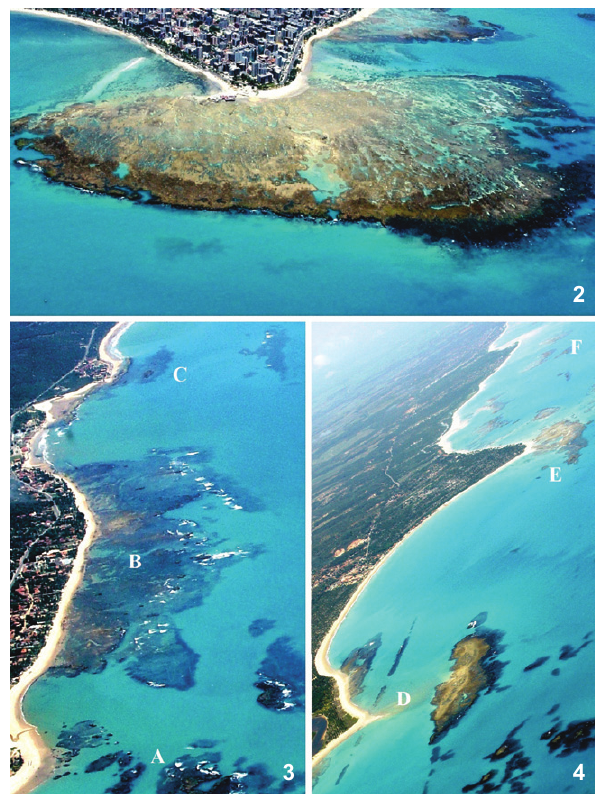
Figures 2-4. Reef ecosystems on the Maceió coast in Alagoas, Bra- zil: (2) Urban area: Ponta Verde coral reef; (3) Central coast: (A)